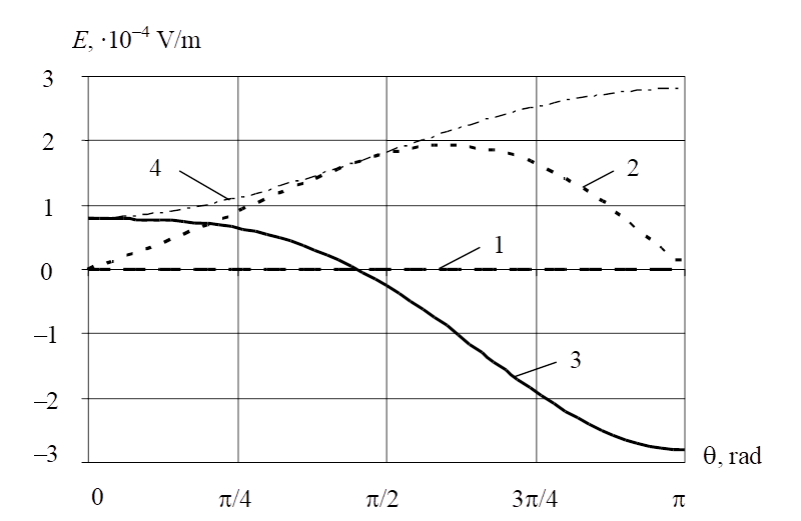
E , 3 – E , 2 – E , x z y